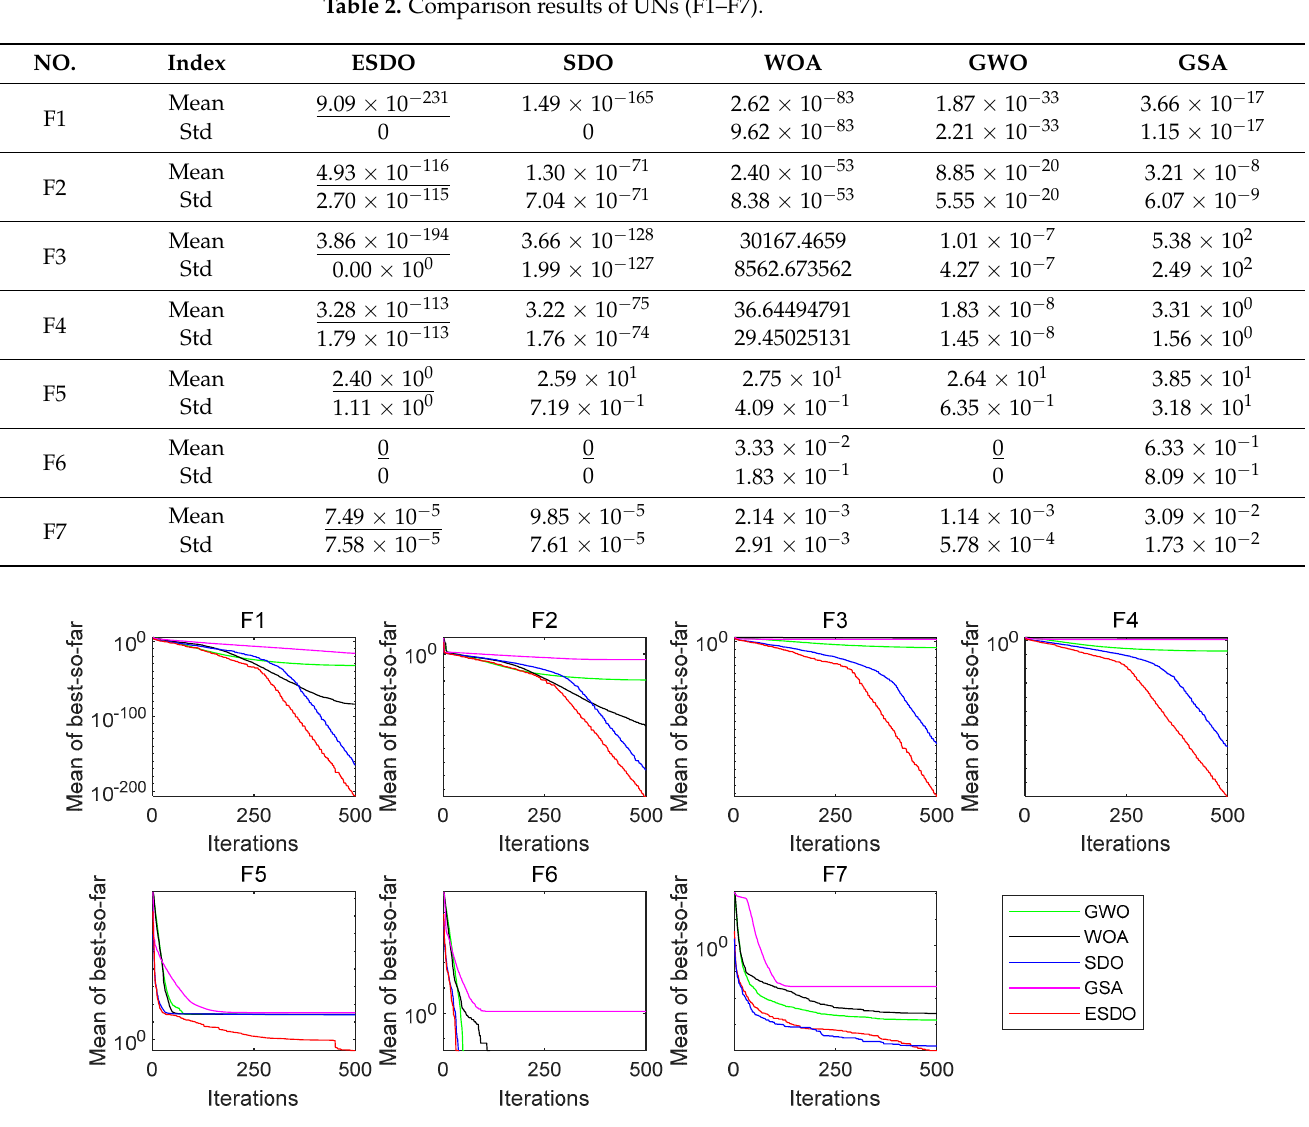
Table 2. Comparison results of UNs (F1–F7).